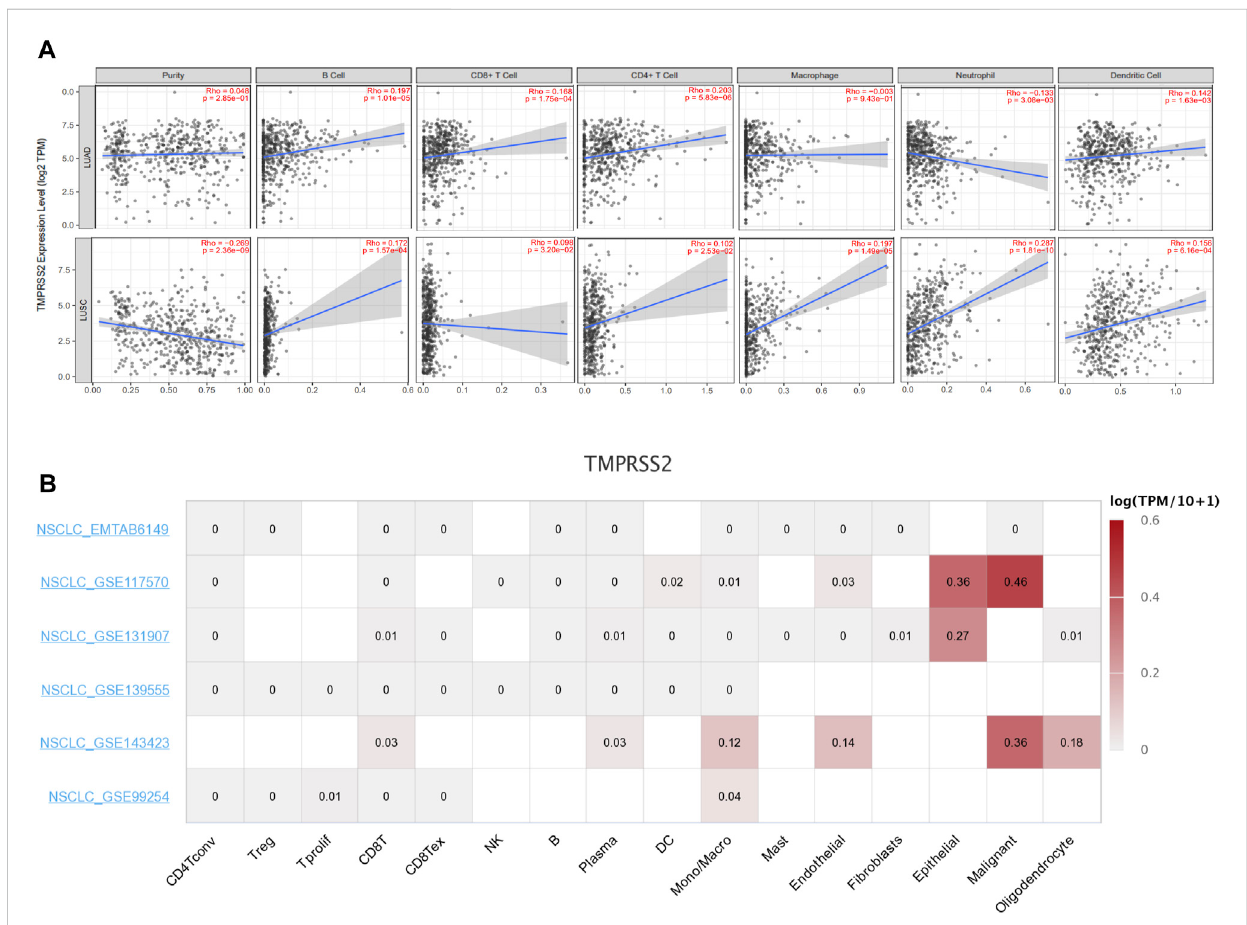
FIGURE 5 Correlation between TMPRSS2 expression and immune in fi ltration level in LUAD and LUSC by using TIMER 2.0.Including B cell, CD8 + T cells, CD4 + T cells, macrophages, neutrophils, and dendritic cell (A) . Average expression of TMPRSS2 in different cell-types across NSCLC datasets by using TISCH. The color indicates gene expression level (B)